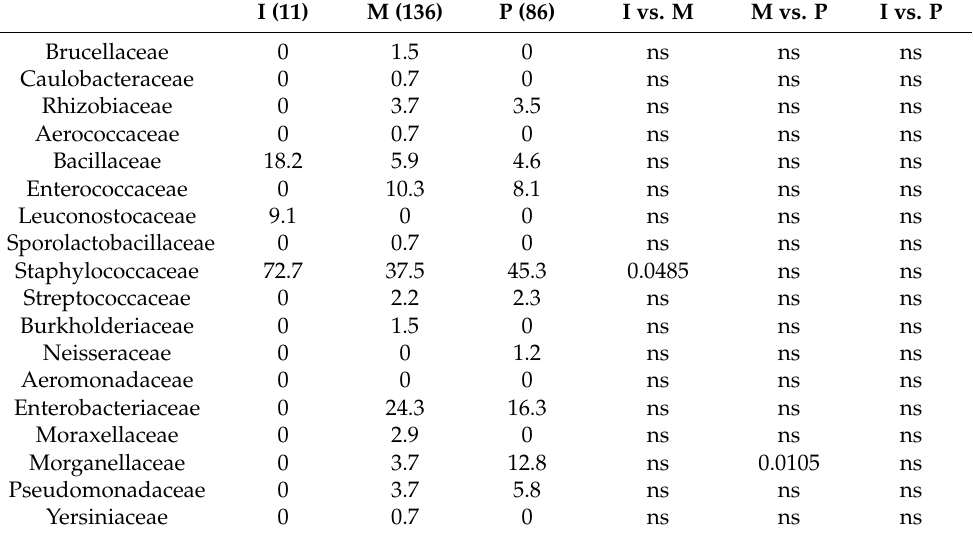
Table 4. Relative abundance (%) of cultivable bacteria at the family level according to reproduc- tive status.